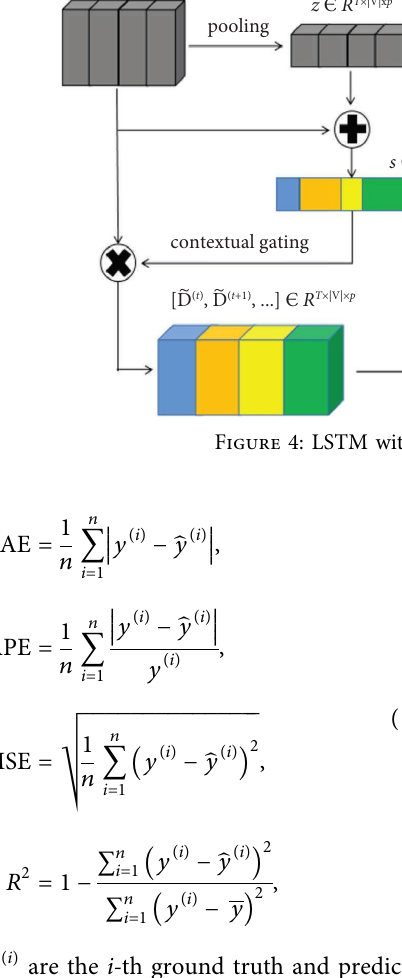
Figure 5: Te investigated region (marked with numbers).